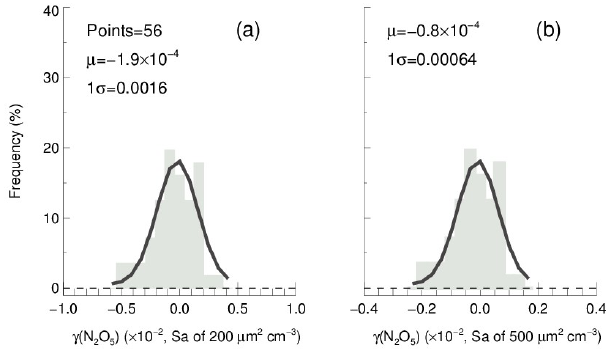
Figure 12. The γ( N 2 O 5 ) derived from blank measurements in a histogram distribution plot. The γ( N 2 O 5 ) was calculated from k N by means of Eq. (2) with S a of (a) 200µm 2 cm − 3 and 2 O 5 (b) 500µm 2 cm − 3 , respectively, under the temperature of 293K. The Gaussian function is fitted to the distribution and plotted in a black line. The 1 σ from the Gaussian fit is regarded as the detection